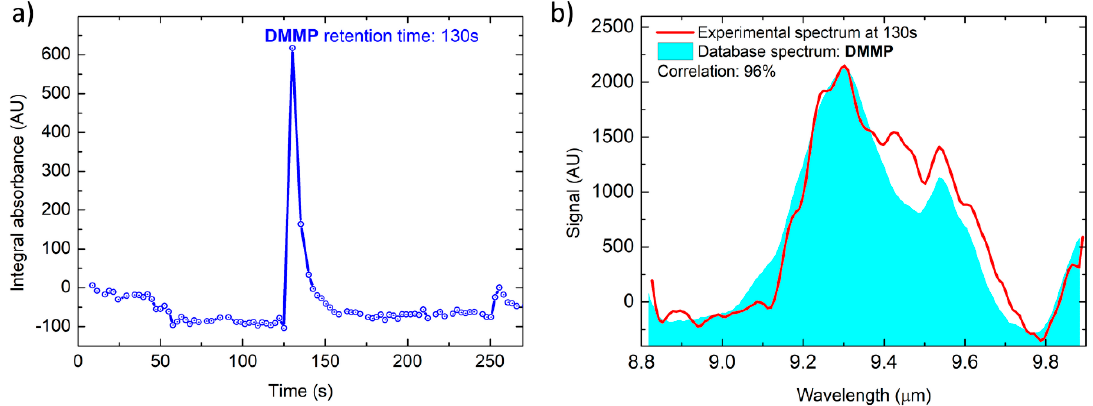
Figure 8. Total absorption chromatogram ( a ) and DMME spectrum acquired at T = 130 s compared with the library spectrum ( b ).